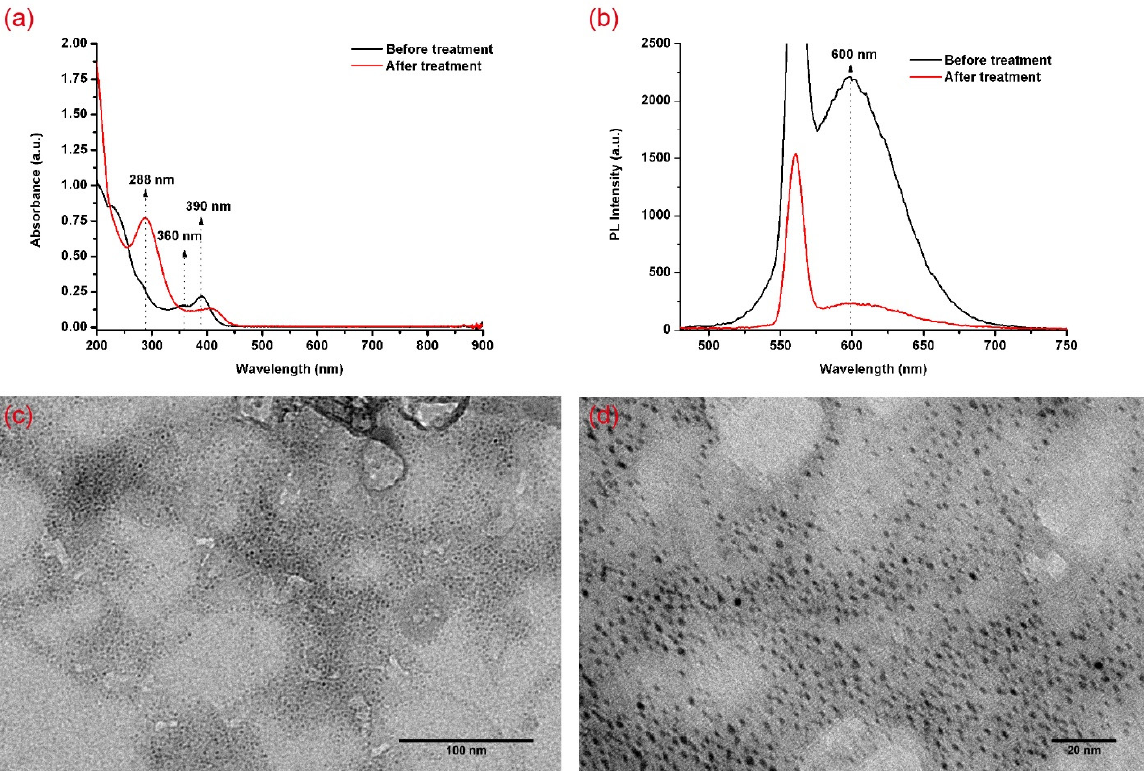
Figure 3. ( a ) The absorption and ( b ) emission spectra of AuNC@MUA before and after NaClO aqueous solution treatment; ( c ) and ( d ) TEM images of AuNC@MUA after NaClO aqueous solution treatment under different magnifications.